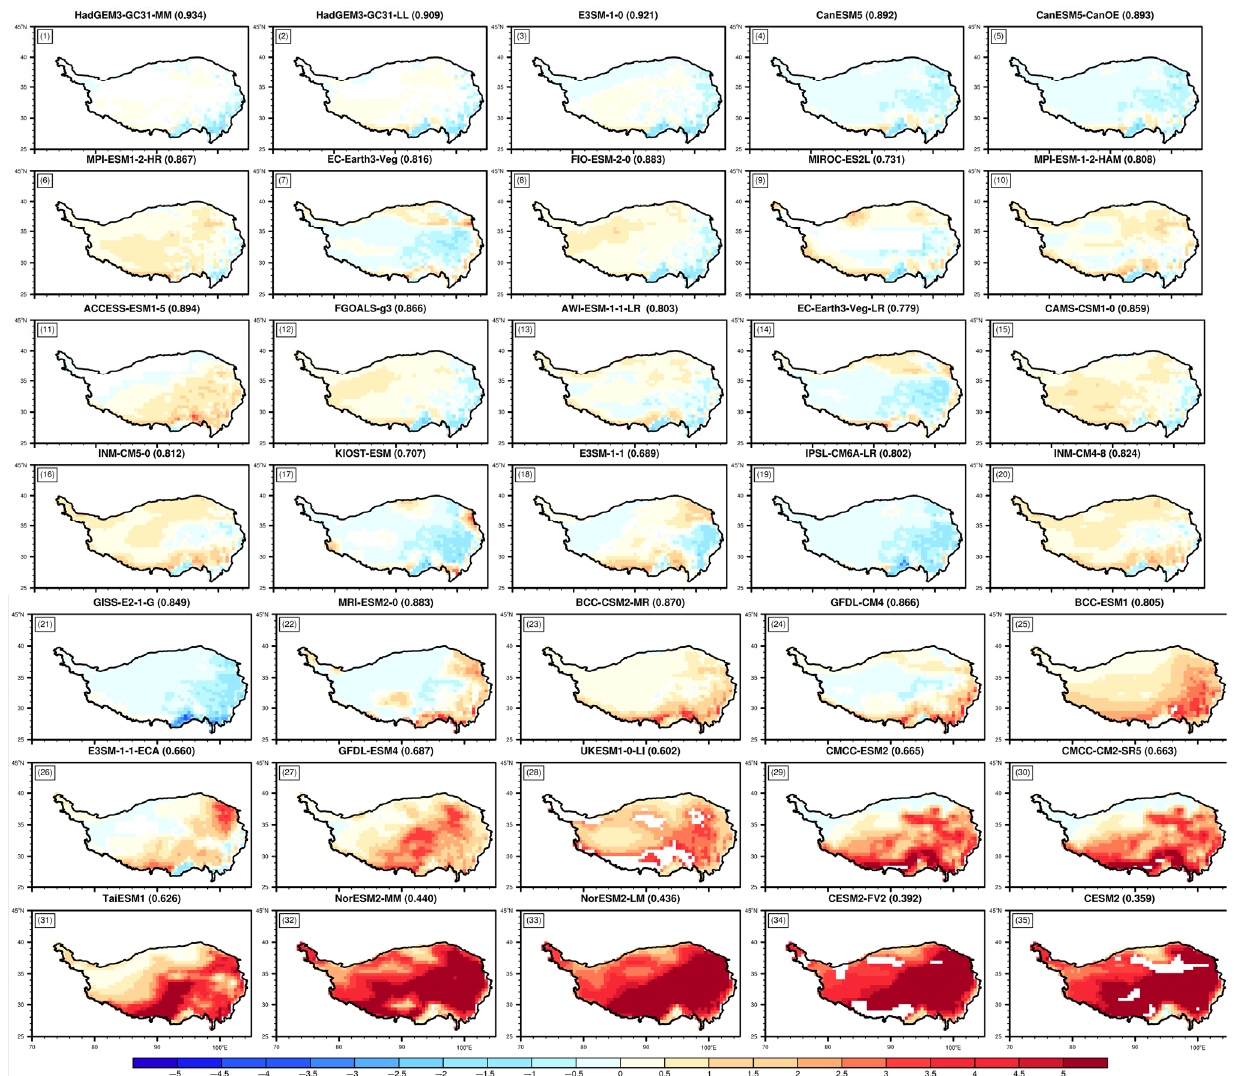
Figure 7. Spatial distribution of the bias of simulated and observed LAI during the growing season. The white part failed the significant difference test. The number in the top left corner is the ranking of each CMIP6 model for simulating the spatial distribution of the average LAI during the growing season in 1981–2014. The value in each title is the pattern correlation.